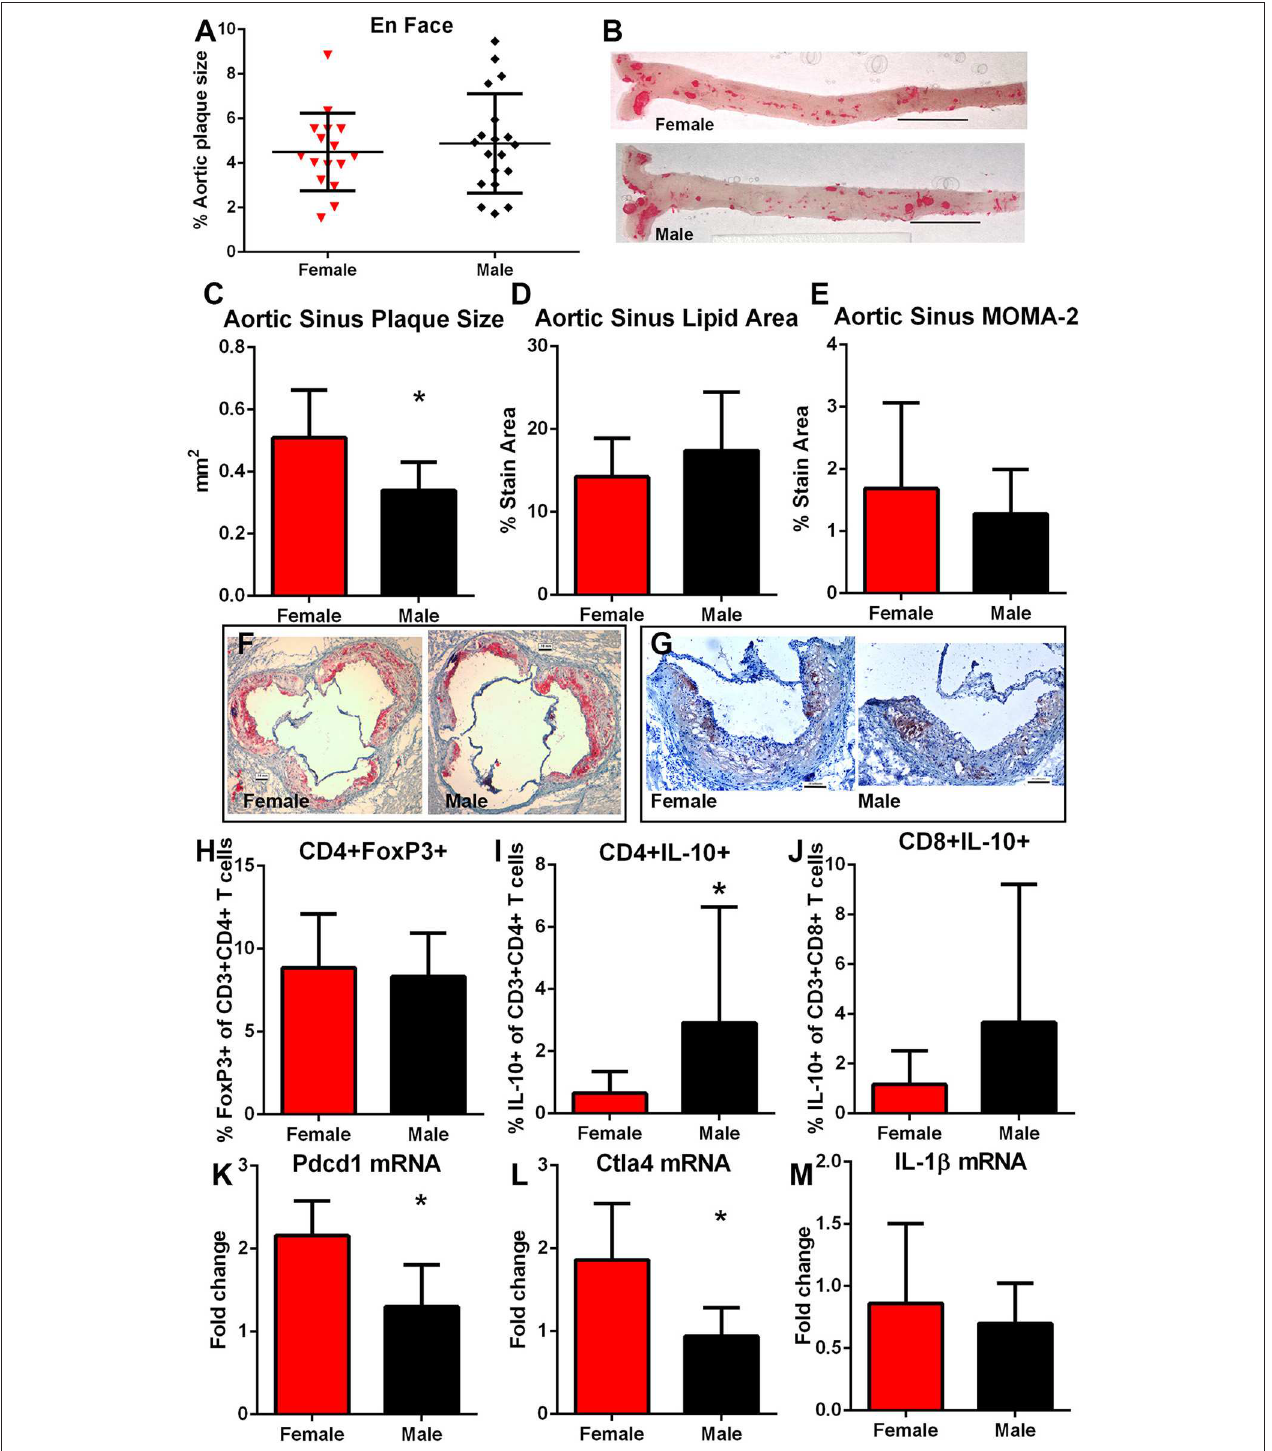
FIGURE 6 | Influence of sex on atherosclerosis and immune regulation. Atherosclerotic burden assessed by en face Oil Red-O staining in aortas of female ( N = 20) and male ( N = 17) apoE–/– mice (A) fed high fat diet for 12 weeks starting at 13 weeks of age [representative photographs in (B) ; bar = 0.5cm]. Aortic sinus plaque size (C) , lipid area (D) , and macrophage stain area (E) measurements with representative photographs of Oil red-O stain (F) and MOMA-2 stain (G) . Bar = 0.1mm. Immune response regulators CD4 + FoxP3 + regulatory T cells [ (H) , female N = 19, male N = 17], Type-2 CD8 + (I) and CD4 + (J) T cells expressing IL-10 (female N = 19, male N = 17) in splenocytes, and splenic mRNA expression of Pdcd1 [ (K) , N = 5 each], Ctla4 [ (L) , N = 5 each], and IL-1 β [ (M) , N = 5 each). * P < 0.05, T -test for (C,K,L) ; Mann–Whitney test for (I) . Gating for flow cytometric analysis of intra-cellular stain as depicted in Figure S1 .